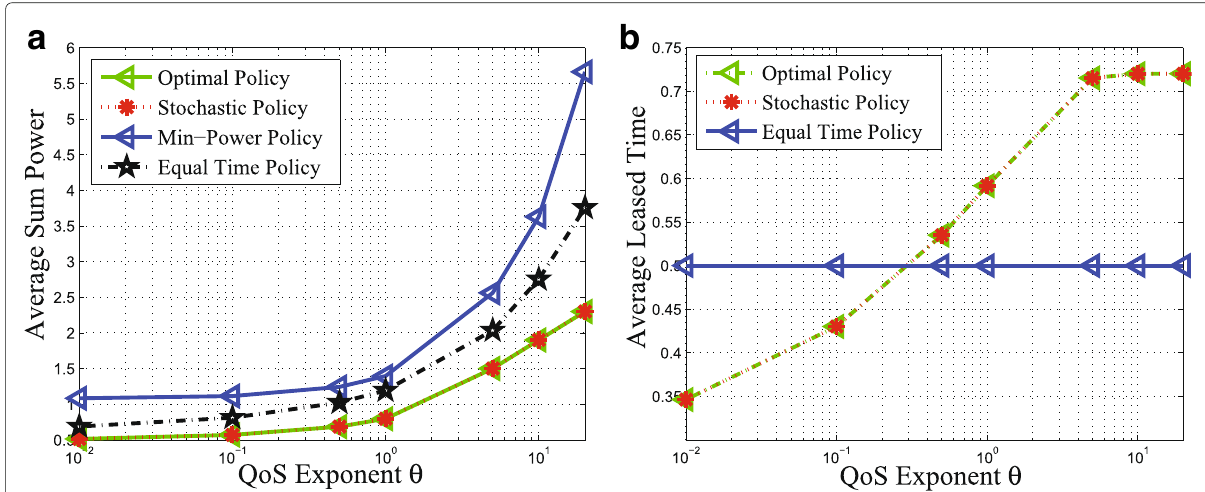
Fig. 6 a , b Average sum power and leased time versus delay QoS exponent θ with DF relay protocol when { ω 1 = 0.5, ω 2 = 0.5 } is adopted